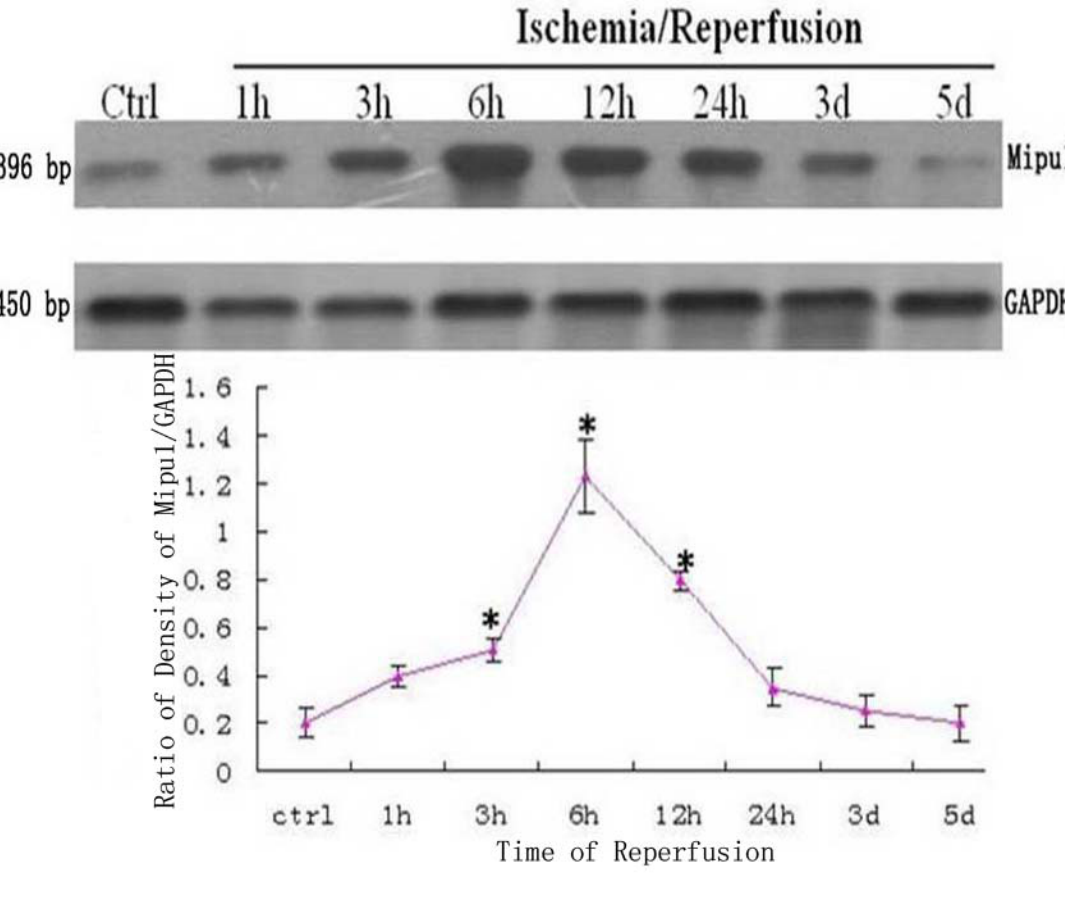
Figure 1. Northern blot analysis for Mipu1 mRNA in an infarct heart. GAPDH bands are shown below. * Statistically significant versus control, P < 0.05,